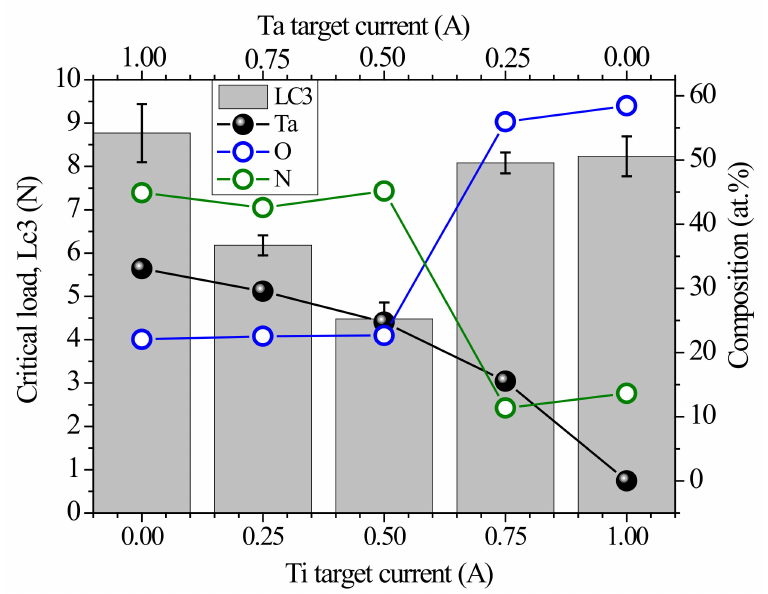
Figure 7. Correlation between critical load Lc 3 and the composition and deposition